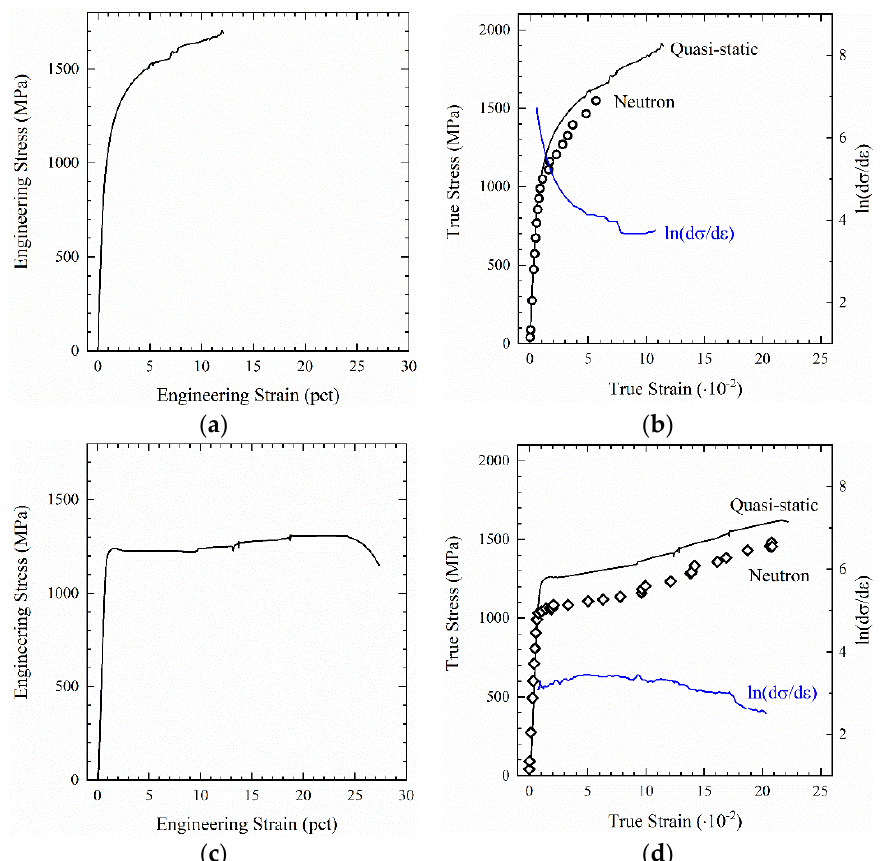
Figure 3. Room temperature engineering and true stress-strain curves for the ( a , b ) double soaked (DS) and ( c , d ) double soaked and tempered (DS-T) samples tested in both quasi-static and in situ neutron diffraction testing conditions along with the instantaneous work hardening rate, ln ( d σ / d ε )